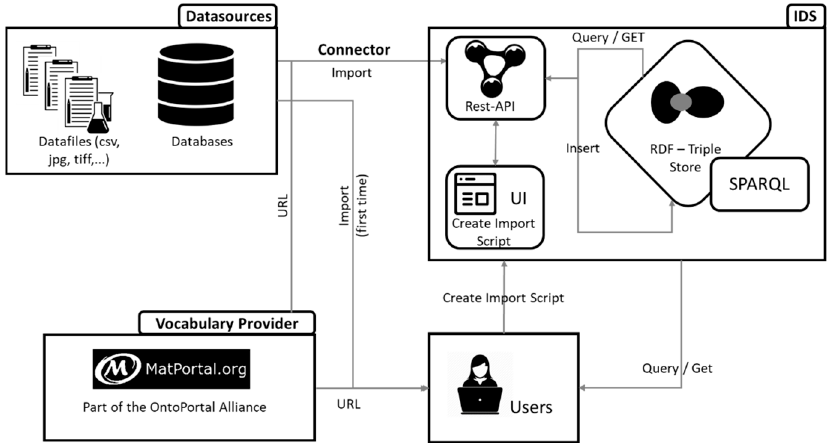
Figure 5. Projected architecture development for the Mat-O-Lab initiative. Datasources refers to the source where raw data from experimental tests is stored. IDS stands for Integrated Data Storage: the different Rest-API allow raw-data to be transformed into triples (see Figure 1) thanks to the connector; the triples are stored in the RDF-Triple